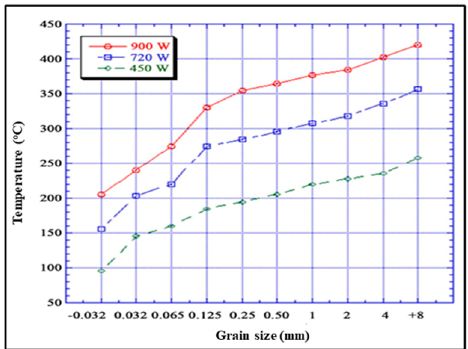
Figure 8. Effect of the grain size and microwave power on the iron ore temperature after the microwave (2.45 GHz) treatment (reproduced with permission: [55]).